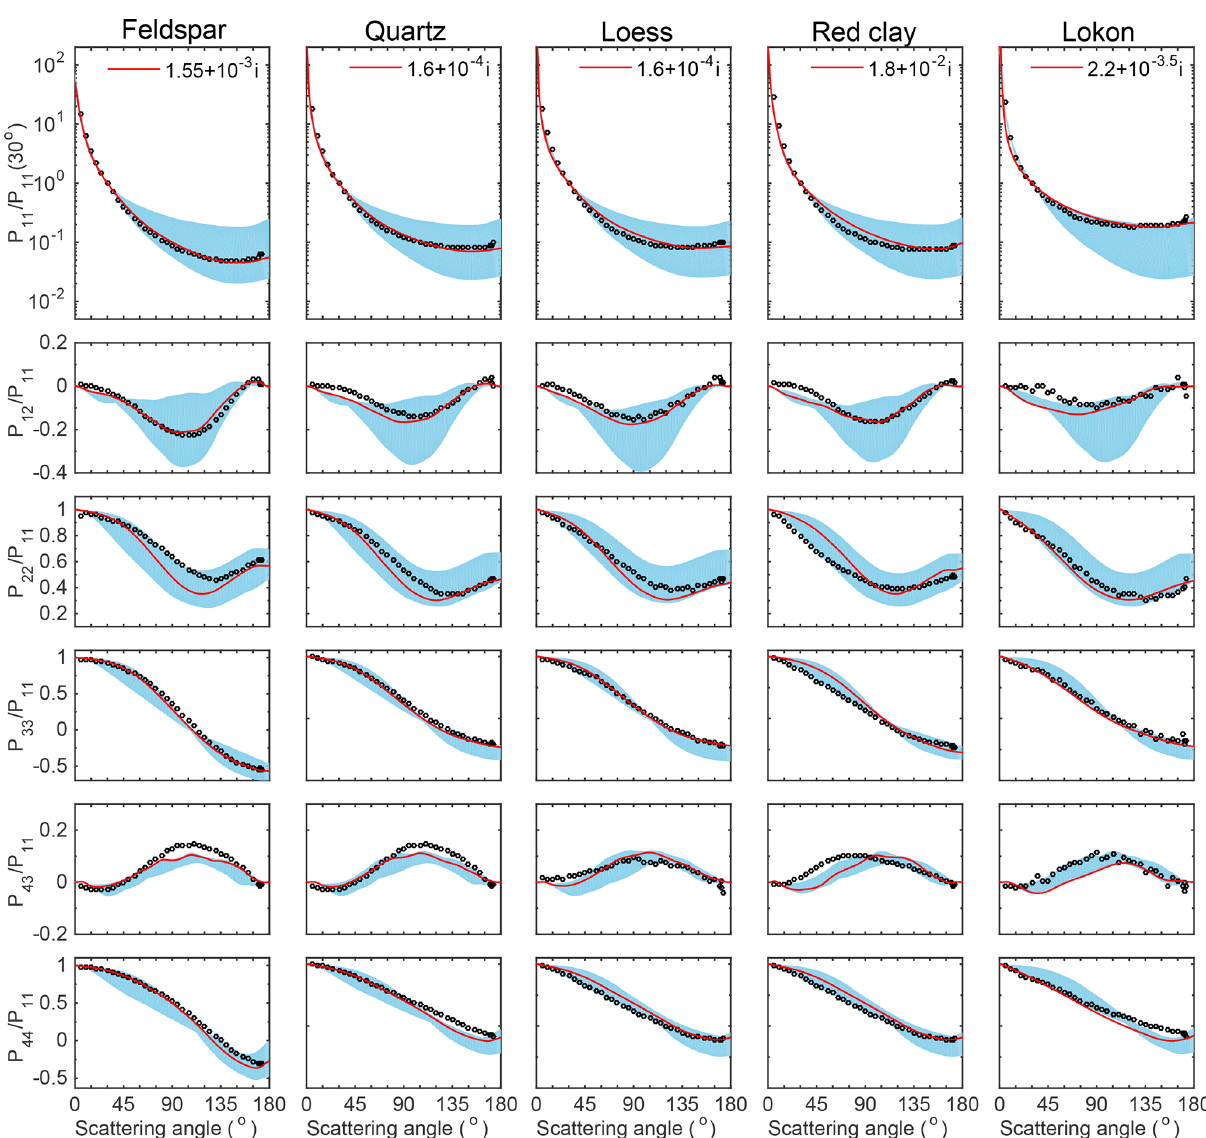
Figure 5. Comparison of the scattering matrix elements of feldspar, quartz, loess, red clay, and Lokon volcanic ash particles with different refractive indices between laboratory measurements (hallow dots) and computed results (shaded areas) at a wavelength of 633nm. The optimal cases are also shown as the red